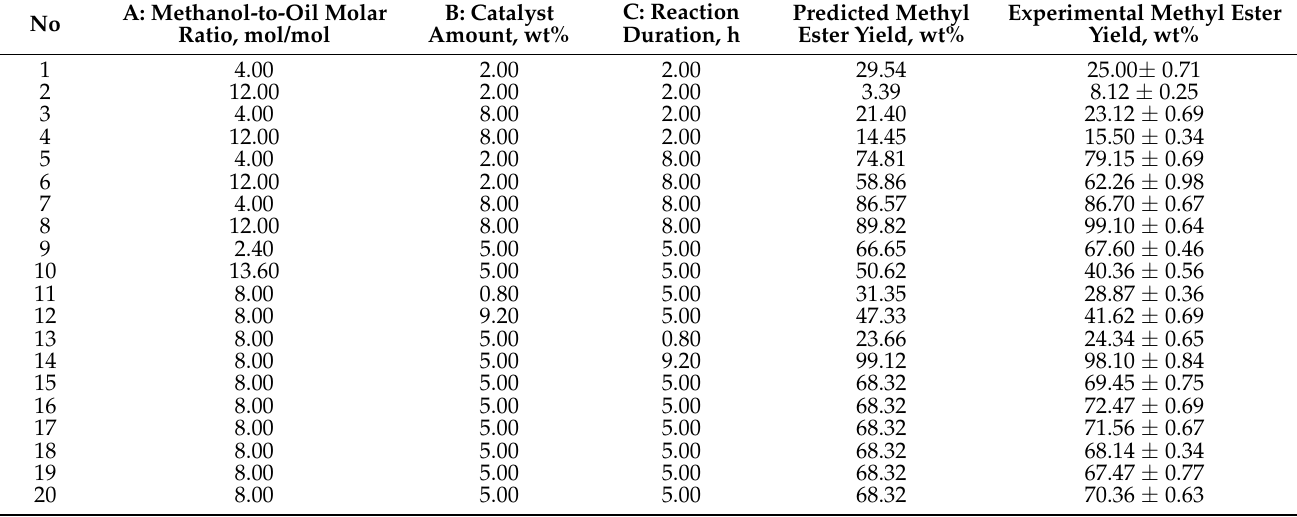
Table 1. Central composite design matrix and observed and modeled